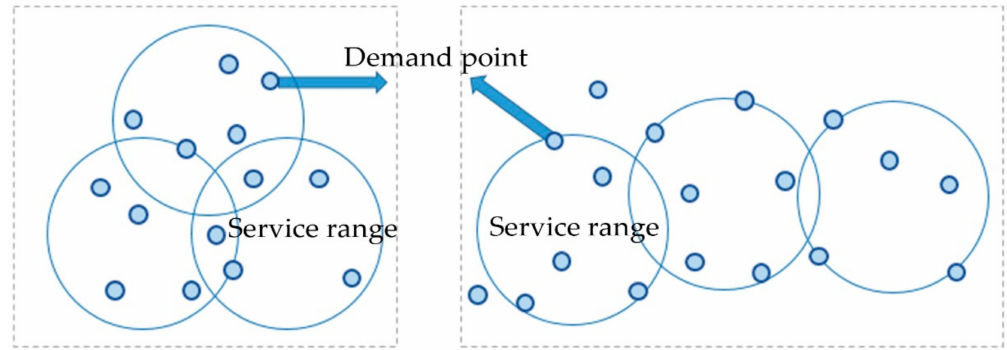
Figure 1. Schematic diagrams of the set covering model and the maximum covering